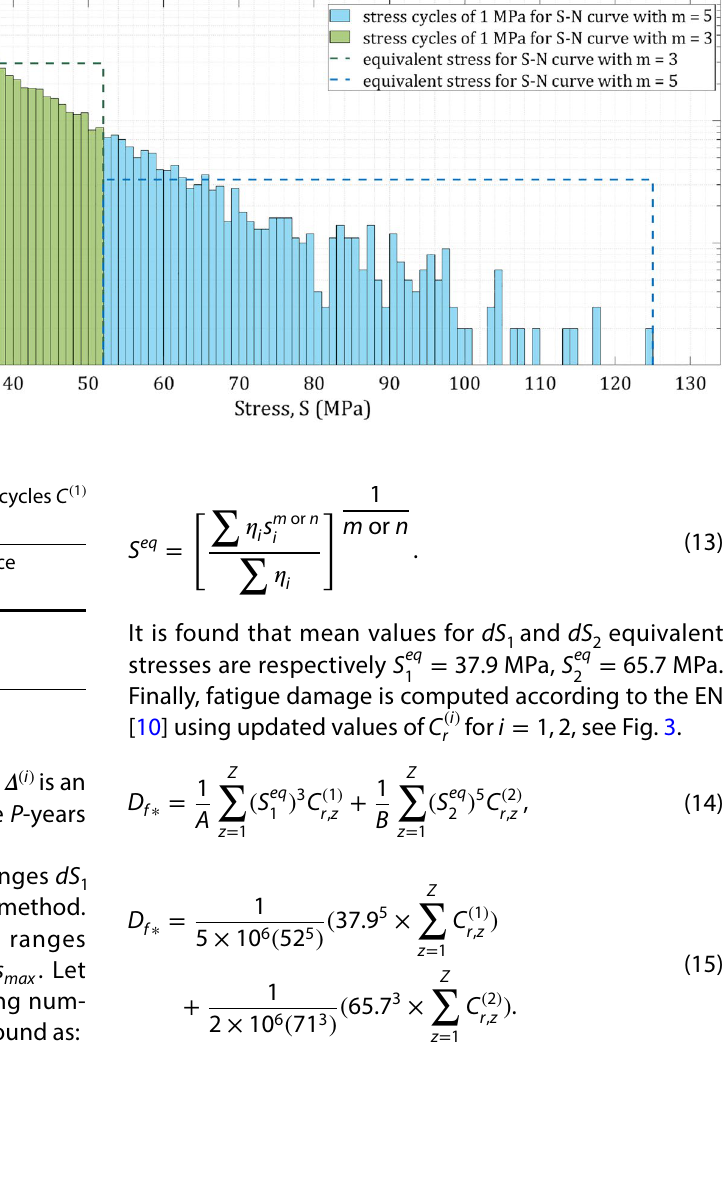
Fig. 10 Histogram of stress cycles with equivalent stresses of 65.7 MPa and 37.9 MPa